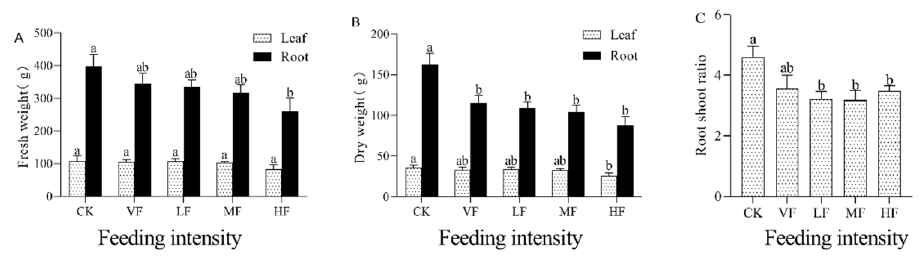
Figure 3. Biomass of C. thunbergii in different foraging intensities (CK, no foraging; VF, very little foraging; LF, light foraging; MF, moderate foraging; HF, heavy foraging) showing ( A ) fresh weight, ( B ) dry weight, ( C ) root: shoot ratio. In each graph, means with the same lowercase letters are not significantly different among foraging intensity ( p > 0.05); means with different lowercase letters are significantly different among foraging intensity ( p < 0.05). Capped lines represent ± standard error.